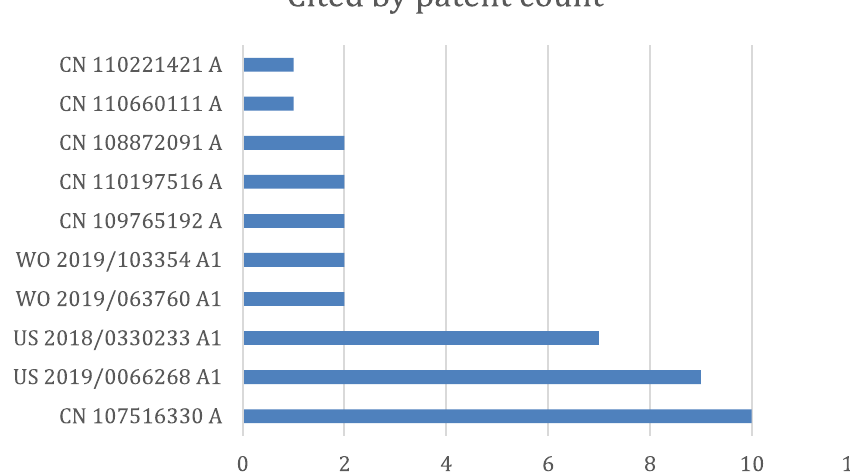
Fig. 9 Most cited patent documents on CT/PET scattering correction, ranked by the number of forward